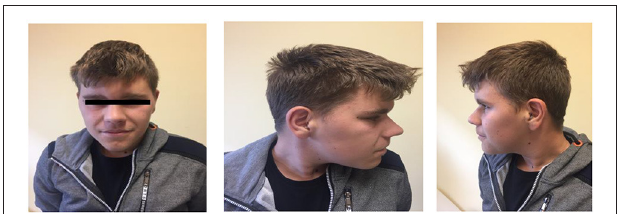
FIGURE 2 | The hands and feet of the patient with a new pathogenic variant NM_001256182.1:c.5117delC NP_001243111.1:p.Pro1706LeufsTer13 in one copy of ANKRD11 gene. Note a brachydactyly and wide fingers and toes.